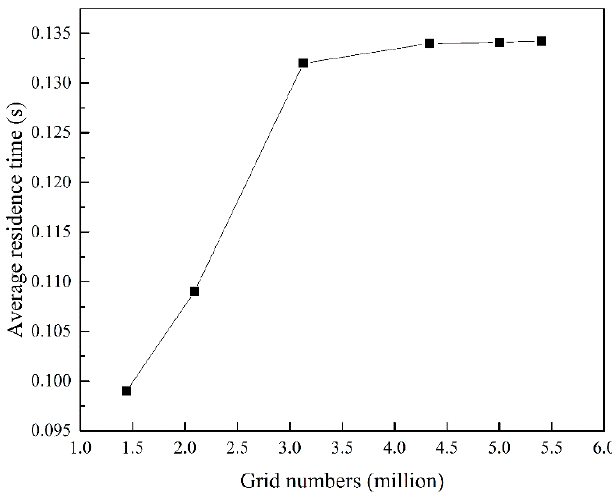
Figure 5. The grid independence checking.